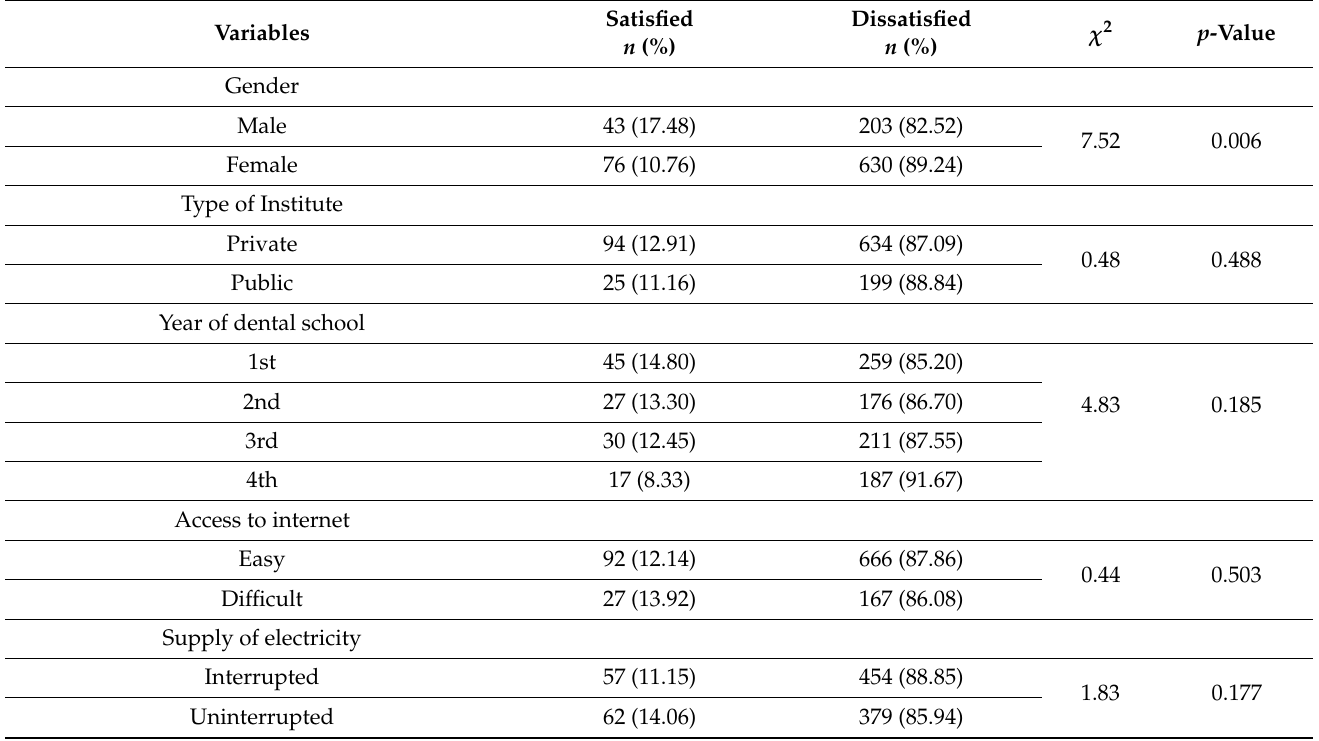
Table 2. Bivariate analysis (Pearson’s chi-square) between several factors and level of satisfaction with online classes .